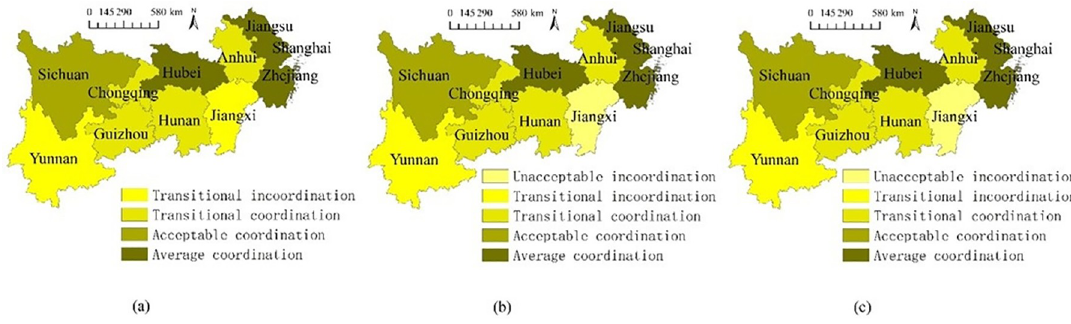
Fig 11. Spatial comparisons of the coordinated growth performance prediction. (a-c)